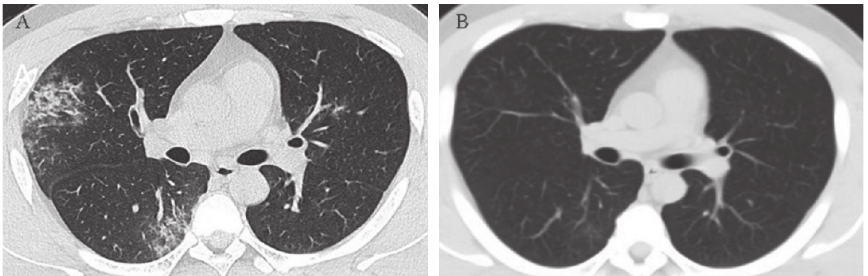
Figure 1: (a) At discharge, lung CT showed multiple patchy and flocculent high-density shadows in both lungs, with blurred edges, especially in the periphery. Some of them showed ground-glass changes and thickened interlobular septa. (b) The lung lesions were absorbed by reexamination three months after